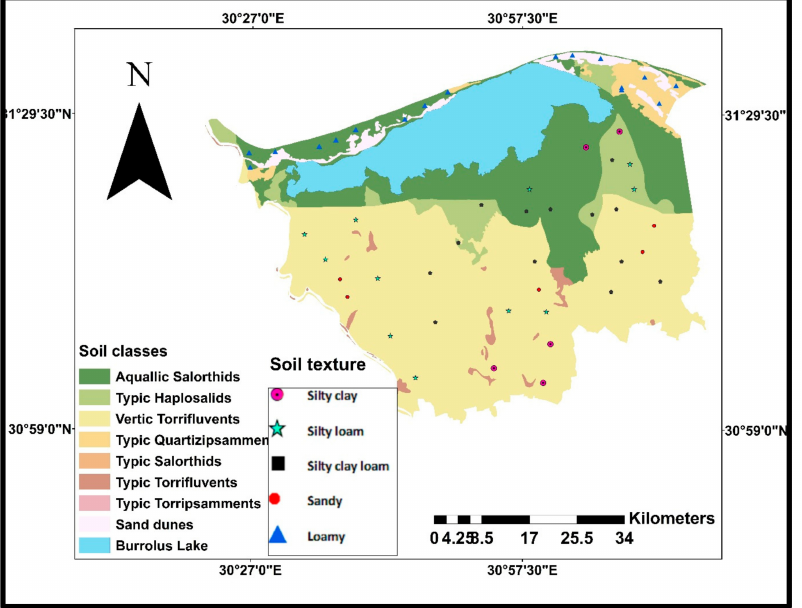
Figure 1. Soil sampling locations in the northern Nile Delta, Egypt, showing the dominant subgroups (U.S. Soil Taxonomy) and the texture of the